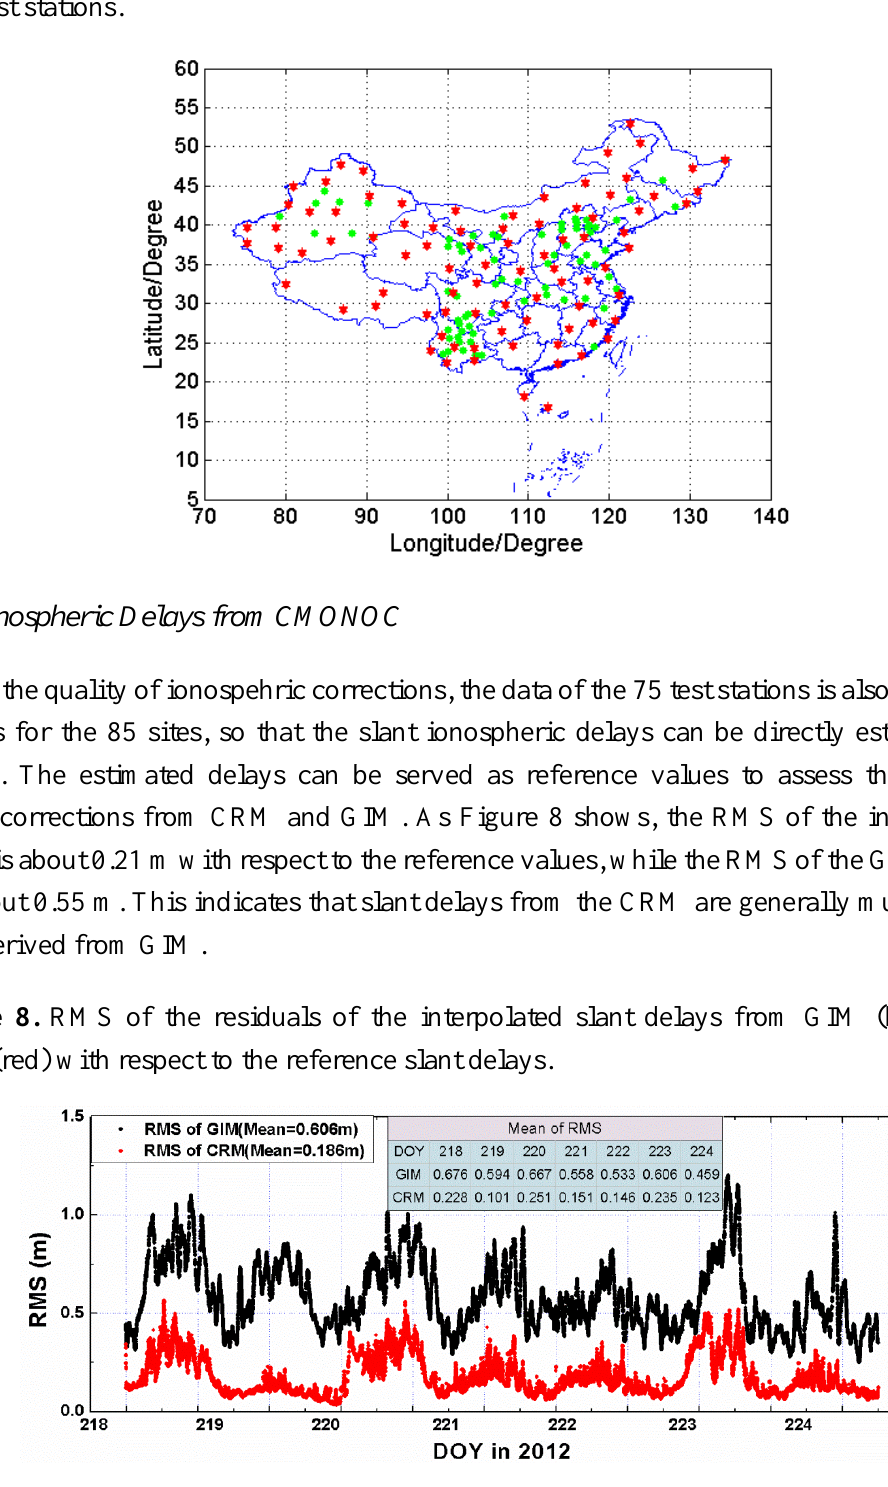
Figure 7. Distribution of the 160 selected CMONOC stations. Red stars represent the reference stations for generating regional ionospheric corrections and green dots indicate PPP test stations.